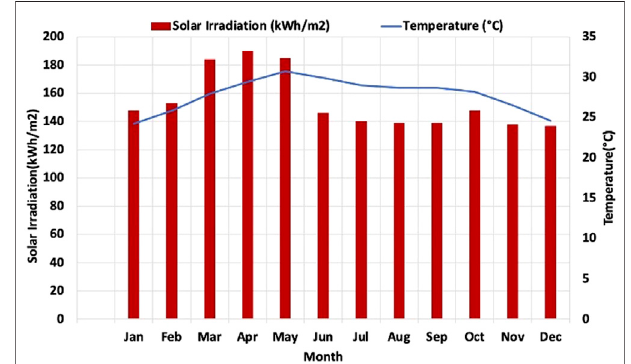
FIGURE 1 | Monthly solar irradiation and ambient